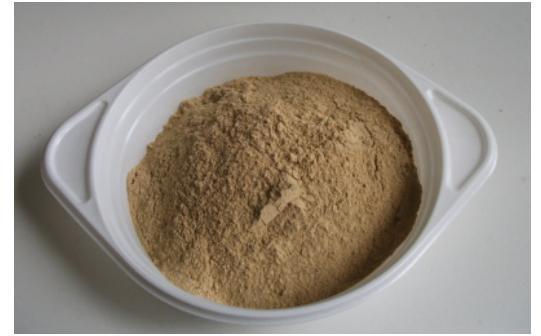
Figure 2. Illitic-kaolinitic clay.